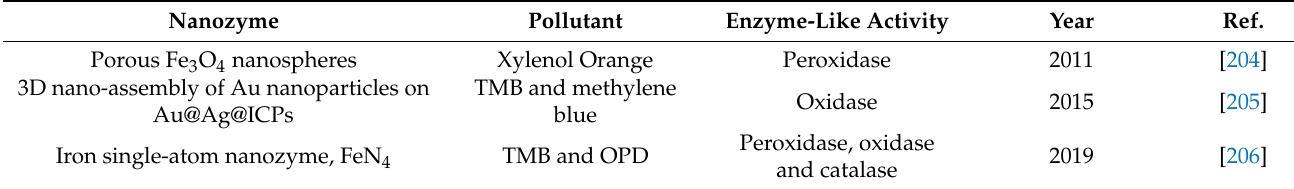
Table 6. Examples of type IV nanozymes in environmental pollutant